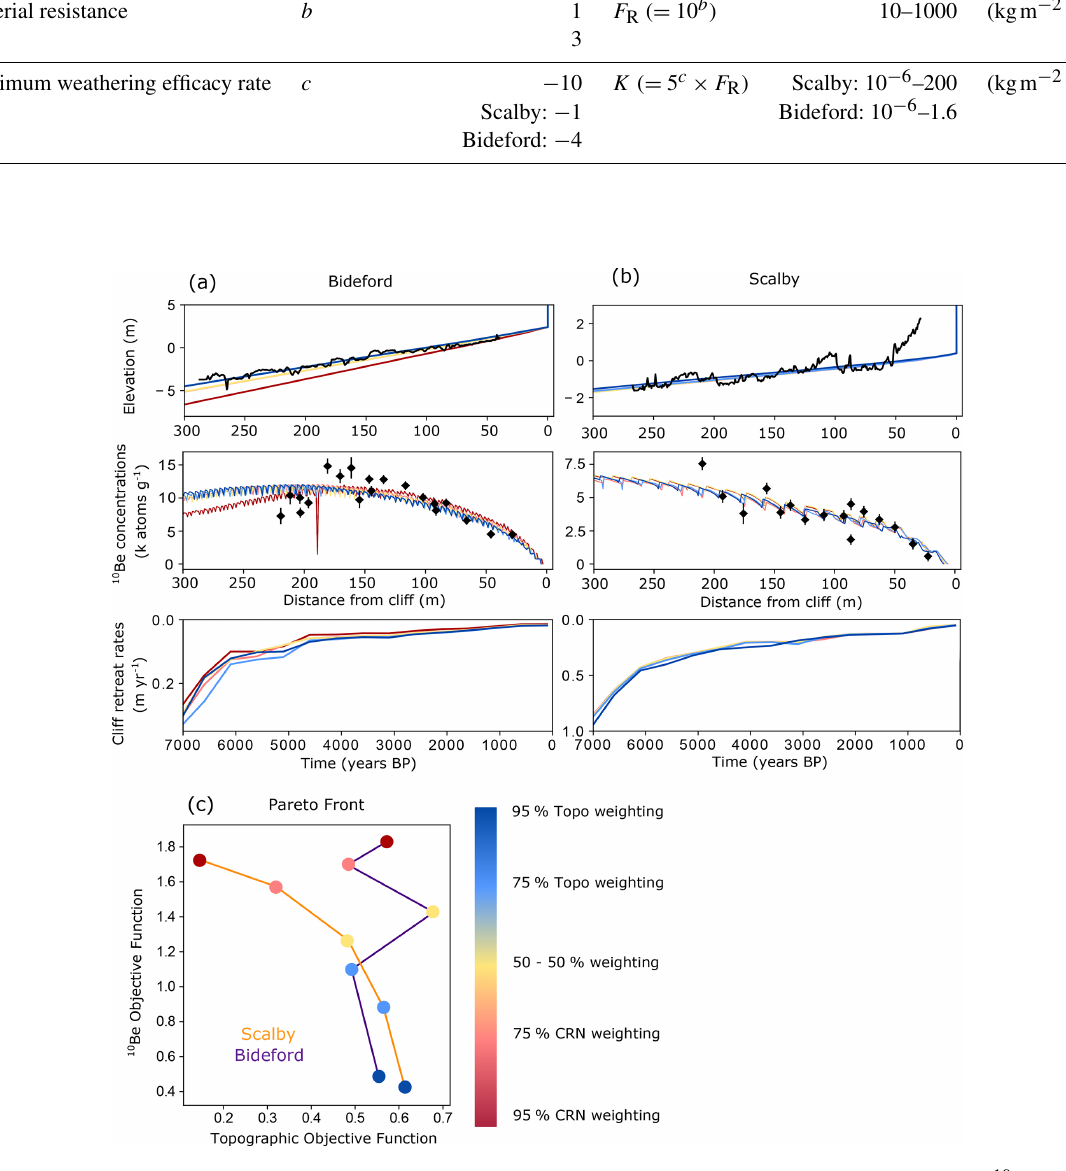
Figure 5. The five Pareto set results for both the Bideford (a) and Scalby (b) sites. The modelled topographic profile and 10 Be concentration profile are shown alongside corresponding measured data. Modelled cliff retreat rates are shown for the past 7000 years. The yellow model results correspond to 50%–50% objective-function-weighted MCMC results. The darkest blue model results correspond to the MCMC results that were most weighted towards the topographic (Topo) profile (95%). The darkest red model results correspond to the MCMC results that were most weighted towards the 10 Be concentration (CRN) profile (95%). The Pareto front of scaled and weighted 10 Be and topographic objective functions is shown for both sites (c)